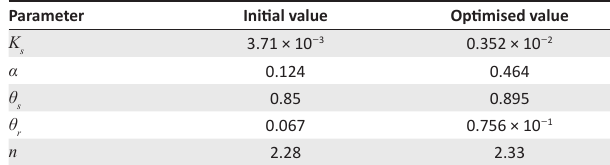
TABLE 2: Reference and optimised model